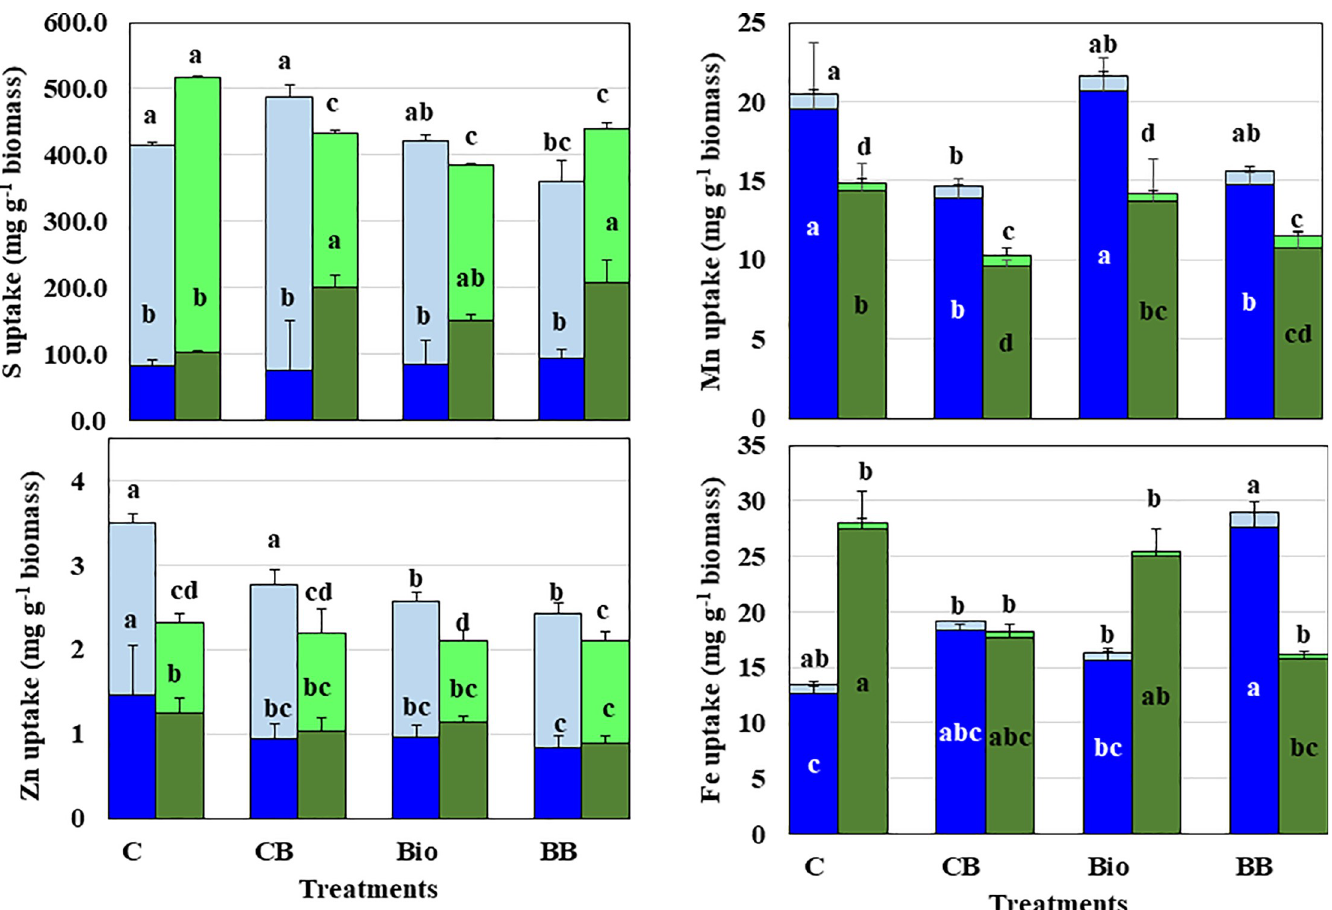
Fig 1. S, Zn, Mn, and Fe uptake in two forage rice genotypes in response to biochar, TUAT-1 biofertilizer and their combination. Blue and light blue bars represent straw and grain uptake in Fukuhibiki, respectively, and green and light green bars represent straw and grain uptake in LTAT-29, respectively. Data are provided as mean ± SD. Values indicated by the same letter are not significantly different at the 5% level by Fisher’s LSD test (p < 0.05).